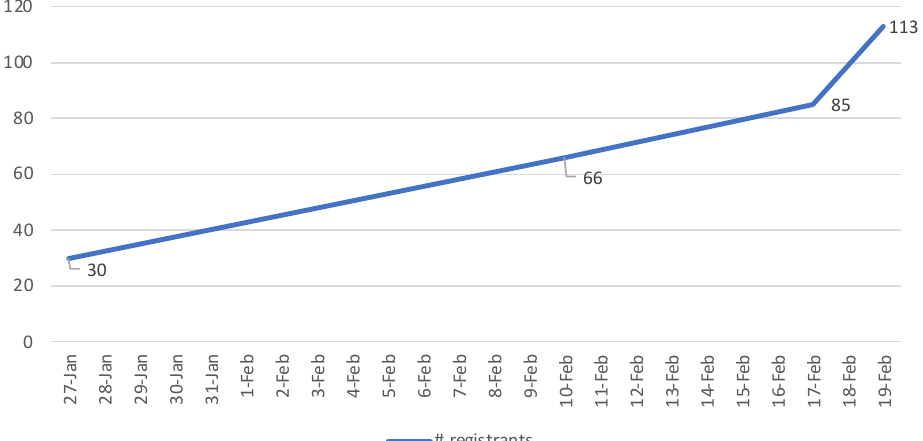
Figure 3. Faith Summit Registration Tracking.